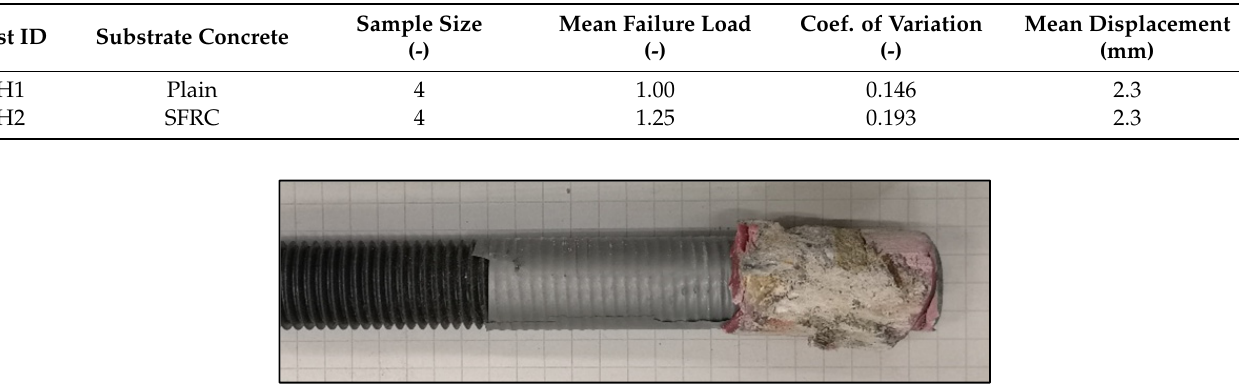
Figure 13. Typical pattern of failure in boreholes with bonded length of 30mm.